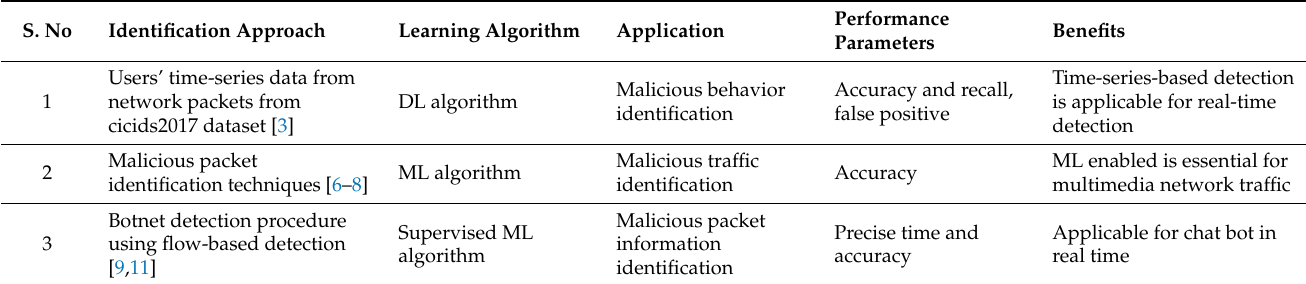
Table 1. Method and applications of malicious information